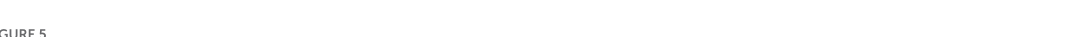
FIGURE5 negative control. The luciferase activity in the cells was assayed. N = 3 per group. ** P < 0.01. (E–G) HUVECs were co-transfected with an miR-125a-5p inhibitor or inhibitor NC and siRNA-ECE1 or siRNA-NC for 48 h. Then the cells were treated with or without starvation for 6 h followed by stimulation with VEGF165 (100 ng/ml) for 20 min. Cell proliferation (F) and migration (E,G) were determined via CCK-8 and scratch assay respectively. Representative images (E) and a quantitative analysis (H) of tube formation. * P < 0.05, ** P < 0.01, *** P < 0.001. Each experiment was repeated 3–5 times. Scale bar = 100 µ m, as presented in the above images. The data are means ±